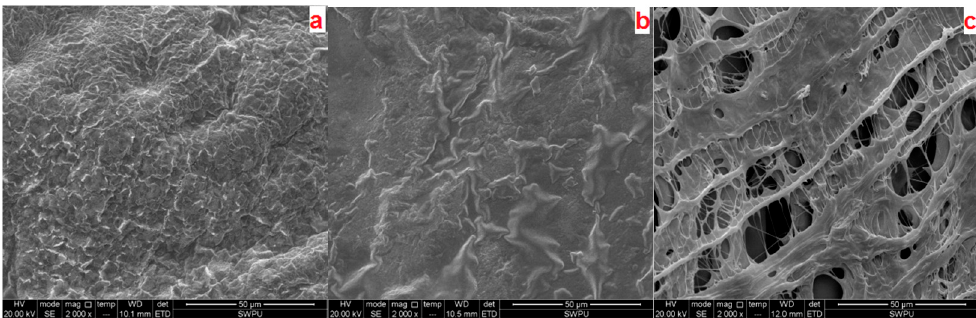
Figure 15. SEM of 0.15 wt.% drag reducers in brine (10 × 10 4 mg/L) containing Ca 2+ at 10,000 mg/L: ( a ) PHWAM-1, ( b ) PHWAM-2, ( c ) PHWAM-3.